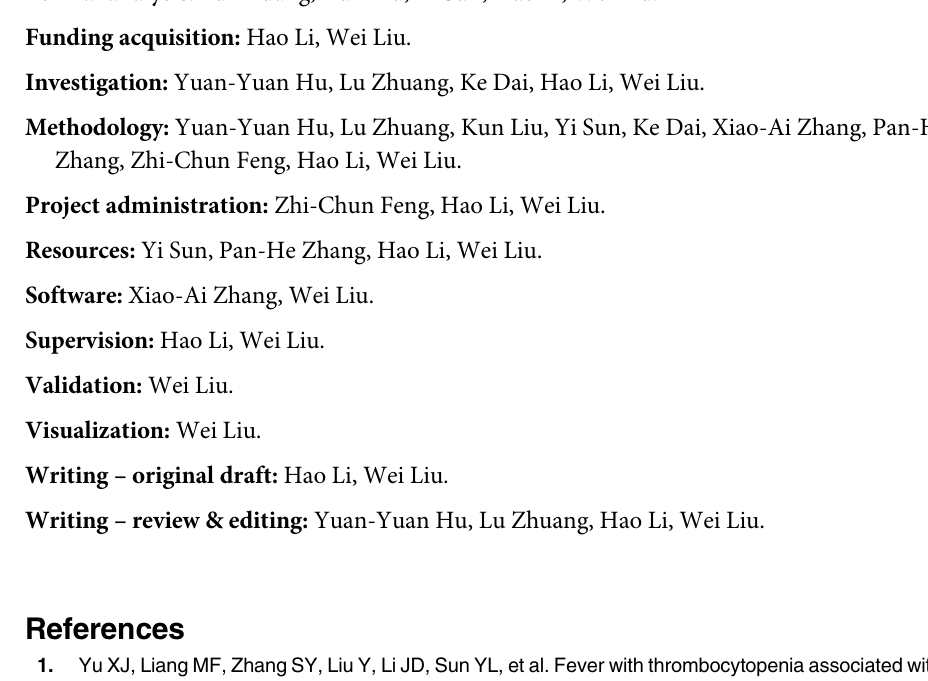
S1 Table. The mean ( ± standard error) days of each development stage for four tick spe- cies. S2 Table. Number of artificially infected ticks in the study. S3 Table. Ticks and egg number ( ± standad error) used in the transovarial transmission. S4 Table. Ticks number used in the transstadial transmission of SFTSV for three tick spe-